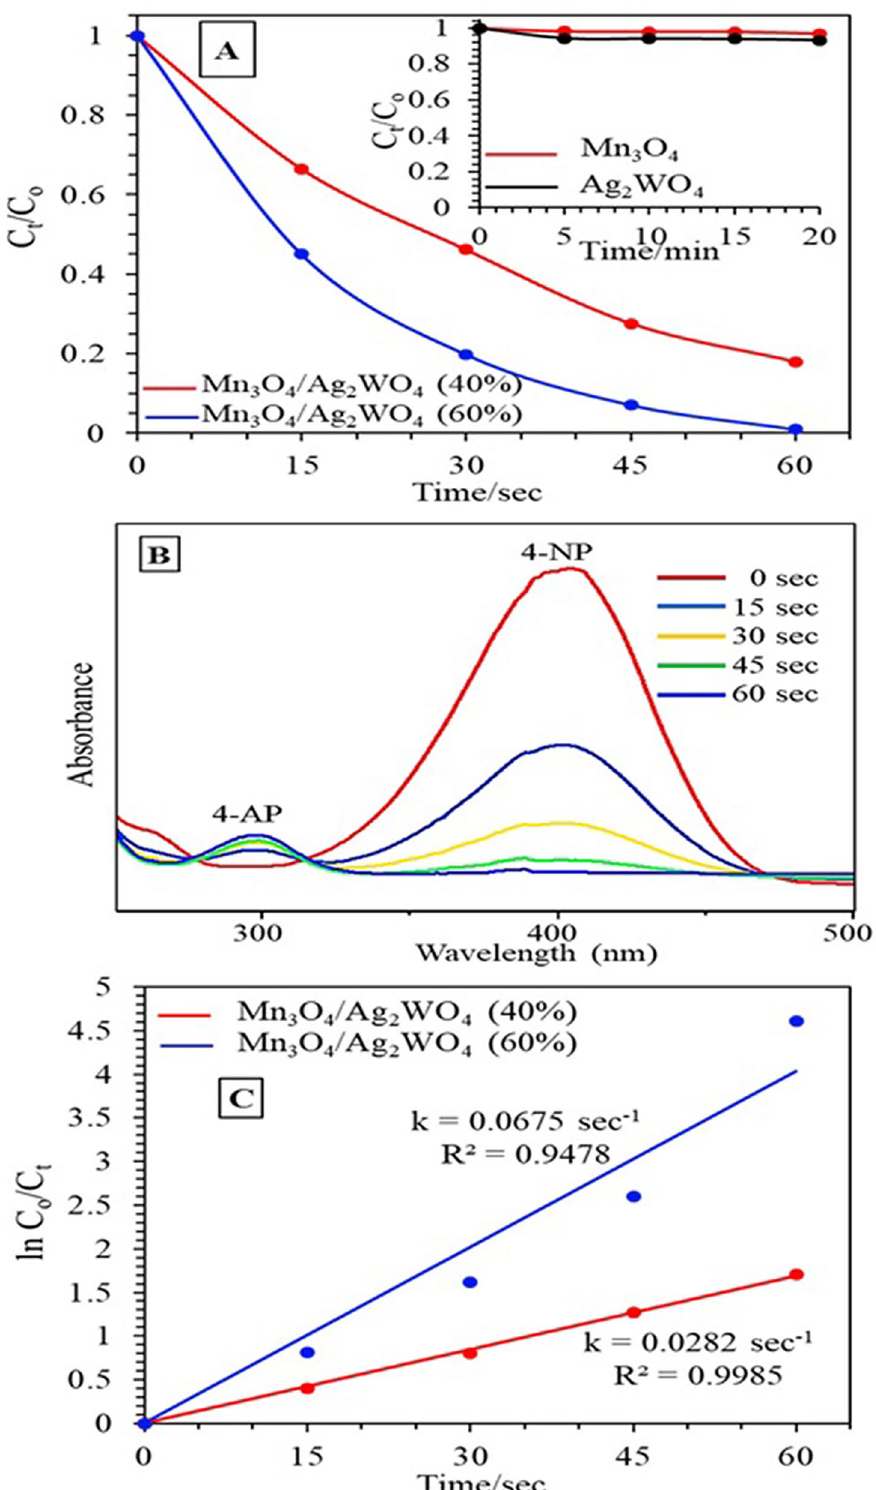
Figure 8. ( A ) The change in the concentration of 4-NP with time on the Mn 3 O 4 /α-Ag 2 WO 4 (60%) photocatalyst, ( B ) UV–vis absorption spectra of the reduction of 4-NP and ( C ) Plots of Ln (C t /C 0 ) versus time for the reduction of 4-NP (Reaction conditions: 3 mL 4-NP of conc. 0.001 M, NaBH 4 conc. of 0.3 M, 3 mg catalyst (1 g/L), T = 289 K, Led lamp 50